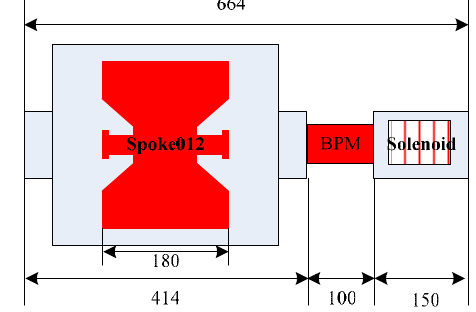
FIG. 11. Layout of one focusing period in Injector Scheme-I.